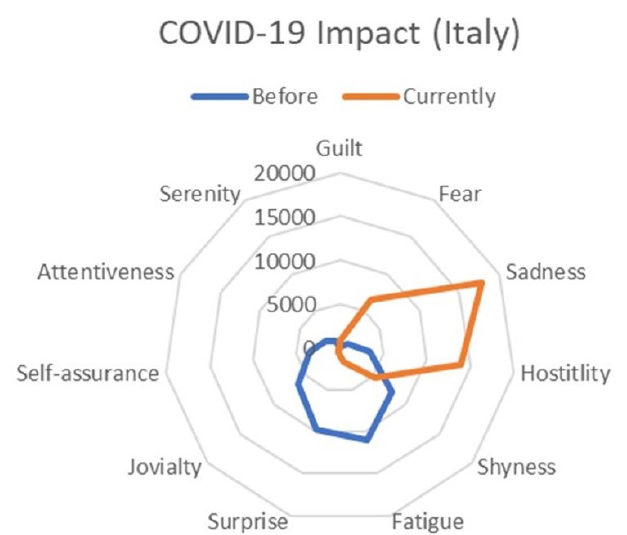
Figure 7. Radar Chart – Impact COVID-19